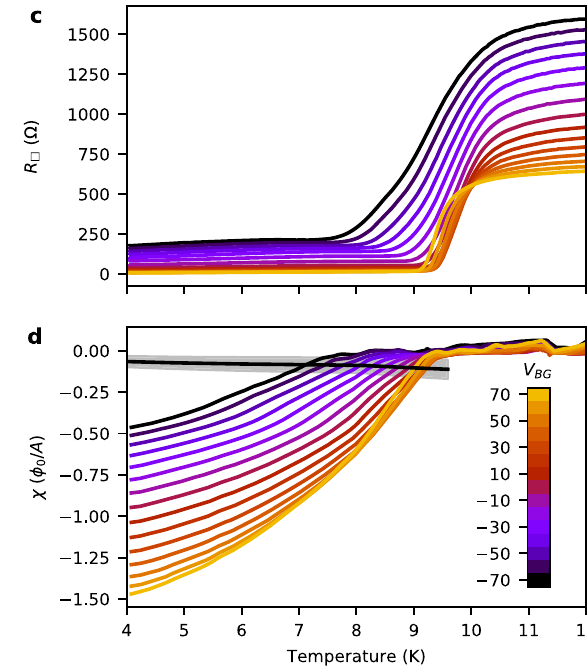
Fig. 2 | Temperature dependence of the gate-tuned resistance and super fl uid response. a Sheet resistance, R □ , and b super fl uid response, χ , of device A versus temperature. Different colors correspond to different backgate voltage V BG as indicated by the color bar in b . The black line corresponds to the universal BKT